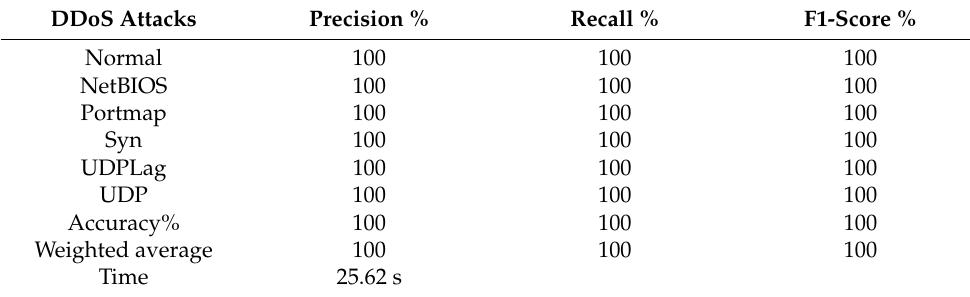
Table 5. Results of CNN–LSTM for detecting multi-classes.